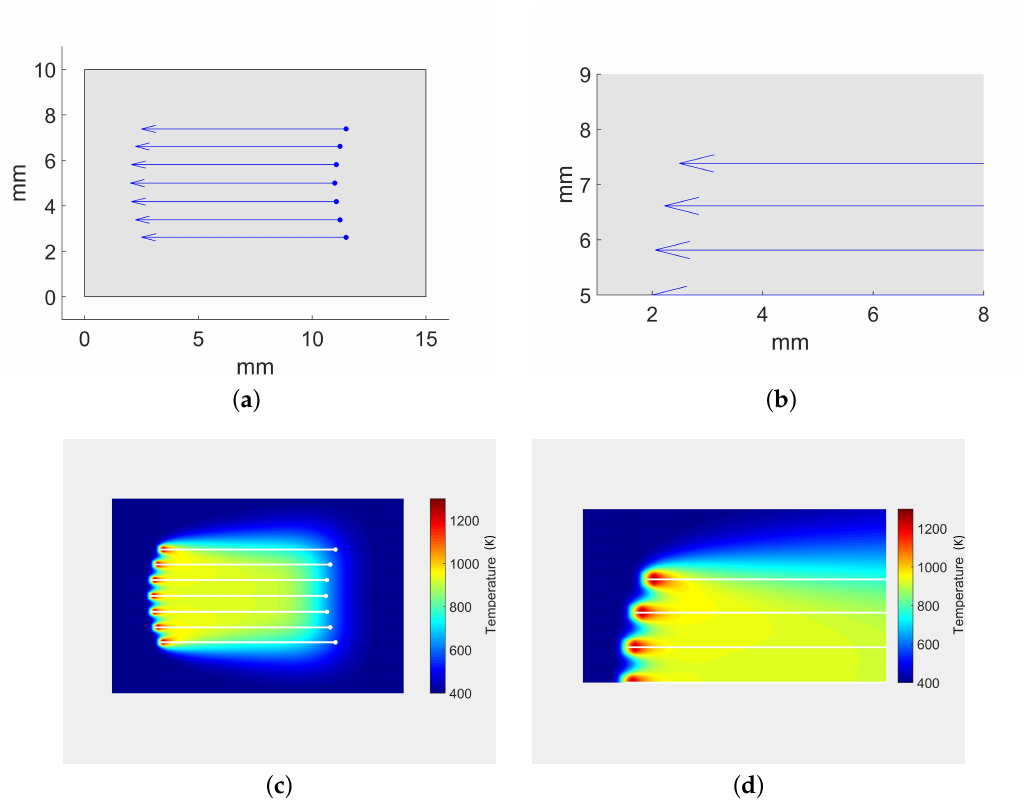
Figure 7. Laser trajectories and temperature results for the simulation case presented in [33]. Similar simulation parameters have been used to replicate the experiment. ( a ) complete sheet. Simultaneous linear trajectories based on [33]; ( b ) laser trajectories (zoom near laser spots); ( c ) temperature map (full sheet); ( d ) temperature map (zoom).